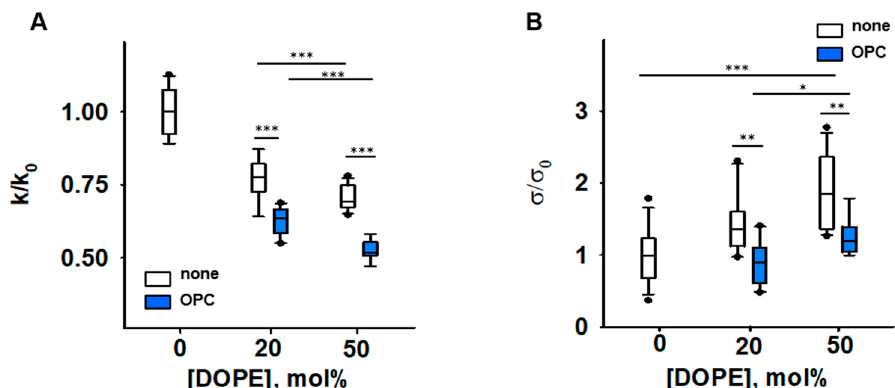
Figure 3. Impact of PE and OPC on the elastic parameters k/k 0 ( A ) and σ / σ 0 ( B ). k 0 and σ 0 are bending modulus and lateral tension in the absence of PE, respectively. Buffer solution contained 100 mM KCl, 10 mM HEPES, 1mM EDTA pH = 7.0, T = 295 K. Data points represent mean and standard deviation from more than 10 independent experiments. * p < 0.05; ** p < 0.01; *** p < 0.001, t -test.